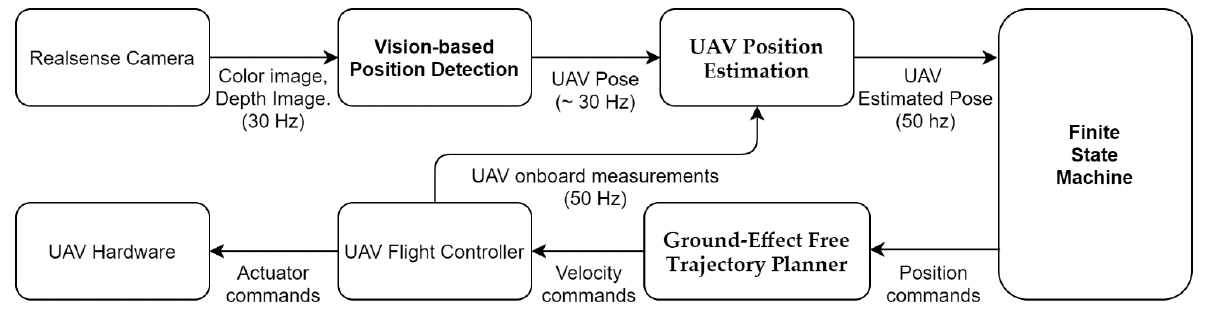
Figure 3. The system architecture of the autonomous landing system.